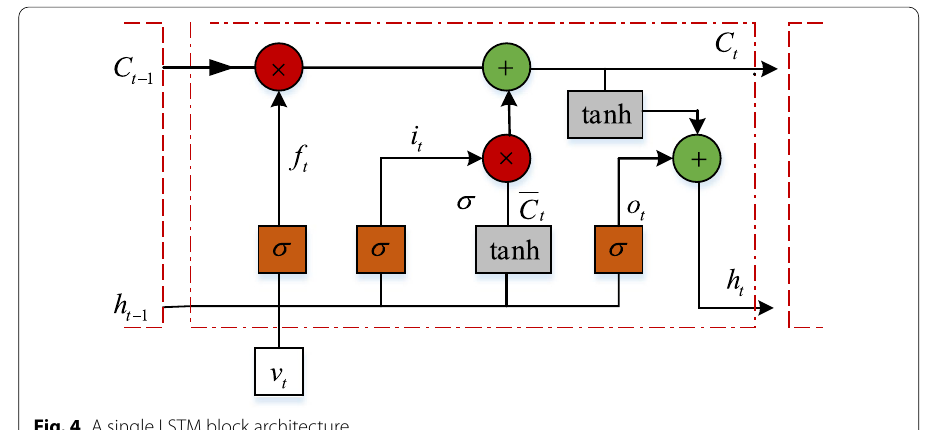
Fig. 4 A single LSTM block